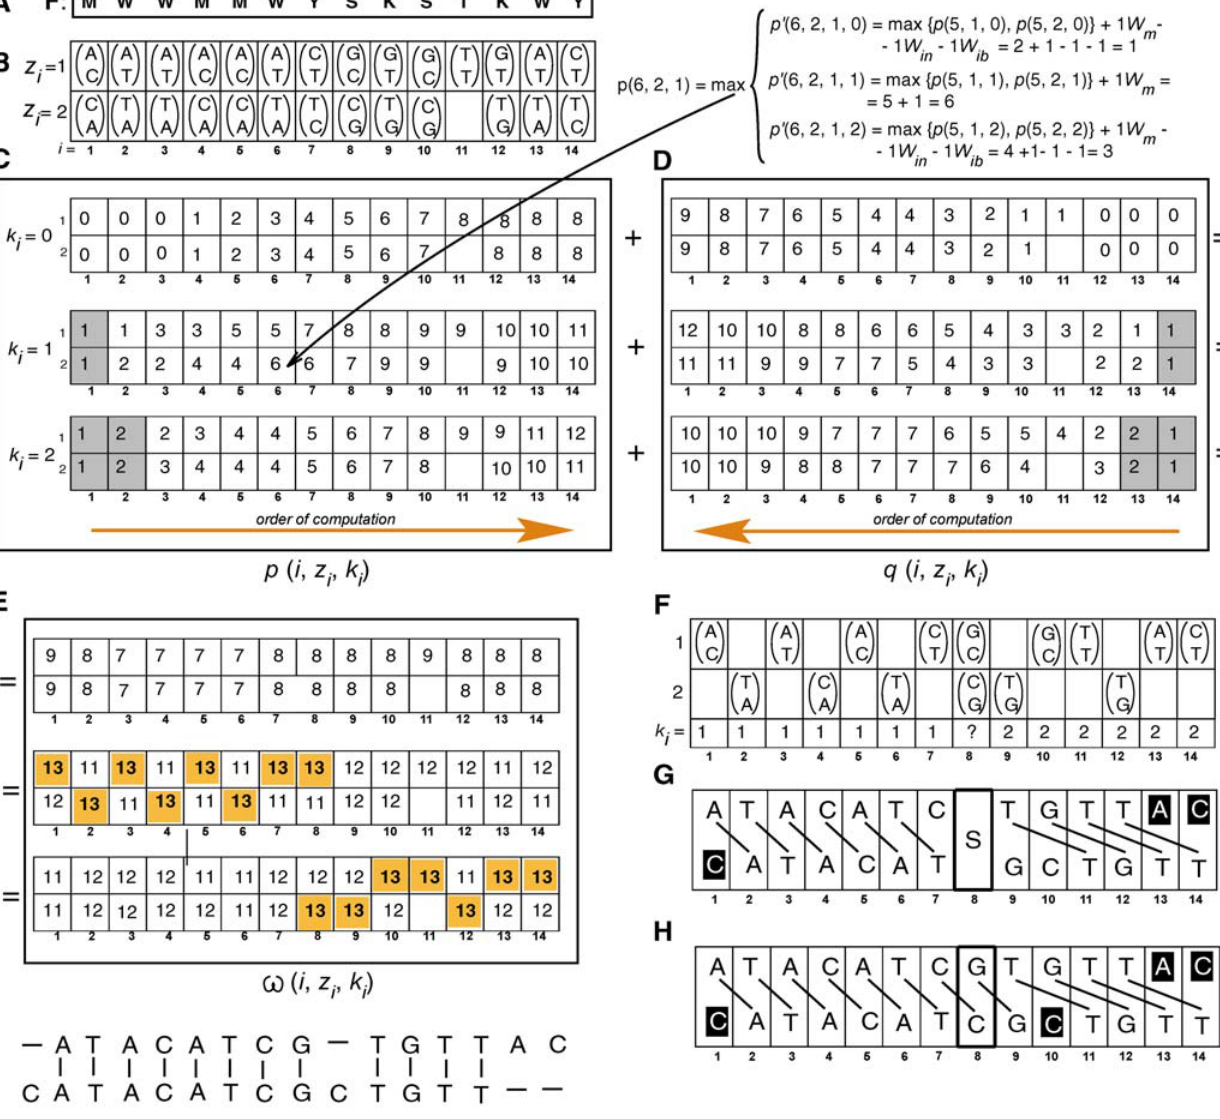
Figure 4. Main steps in decoding of a mixed trace. For the purpose of illustration, K max is set to 2, and the weights W m , W ms , W in , and W ib are all set to 1. Alternative configurations for each site of the input fragment F (A) are stored in the matrix (B). For each k i considered, 0, 1, and 2, a separate matrix is computed for p (C) and for q (D). Matrices for k i . 0 are initialized with basal values at each i # k i , shown in the grey cells. The remaining cells in the p matrices are filled out successively left to right and in the q matrices right to left. Each column has to be computed in all three matrices (one for each k i ) before proceeding to the next site. For i . k i , computing each p and q requires first computing three p 9 and q 9 scores, correspondingly, one for each possible phase shift at the, respectively, preceding or following site. These calculations are omitted for space reasons, except for p (6, 2, 1), included as an example. The matrix of v ( i , z i , k i ) is obtained by summation of p and q matrices; for each i the maximum values v are highlighted (E). The configurations that received the maximum v , and the corresponding k i are selected (F) to form the aligned solution (G). The site 7 remains ambiguous because both corresponding alternative configurations have yielded equal v . The post-processing algorithm determines that only one of these can be incorporated without mismatches (H). The optimal aligned solution is output in the customary form (I). Symbols and conventions are as in Figure 3, except the bases having no homologs are shown on a black background.